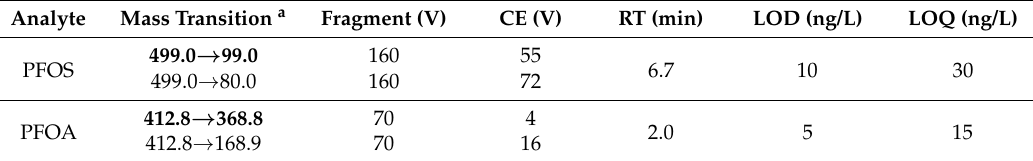
Table 1. MS/MS MRM parameters and calculated LOD and LOQ for PFOS and